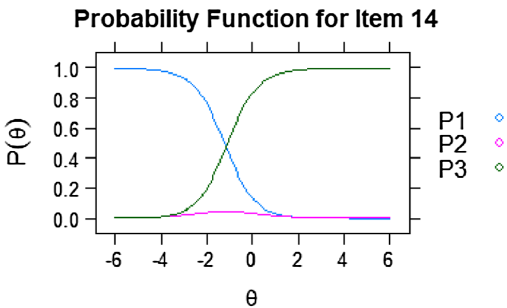
FIG. 7. Probability function of item Q14. P1 (blue) indicates 0 points, P2 (pink) 1 point, and P3 (green) 2 points scored. The axes represent the learner ’ s ability ( x axis, theta) and the probability of solving this item correctly ( y